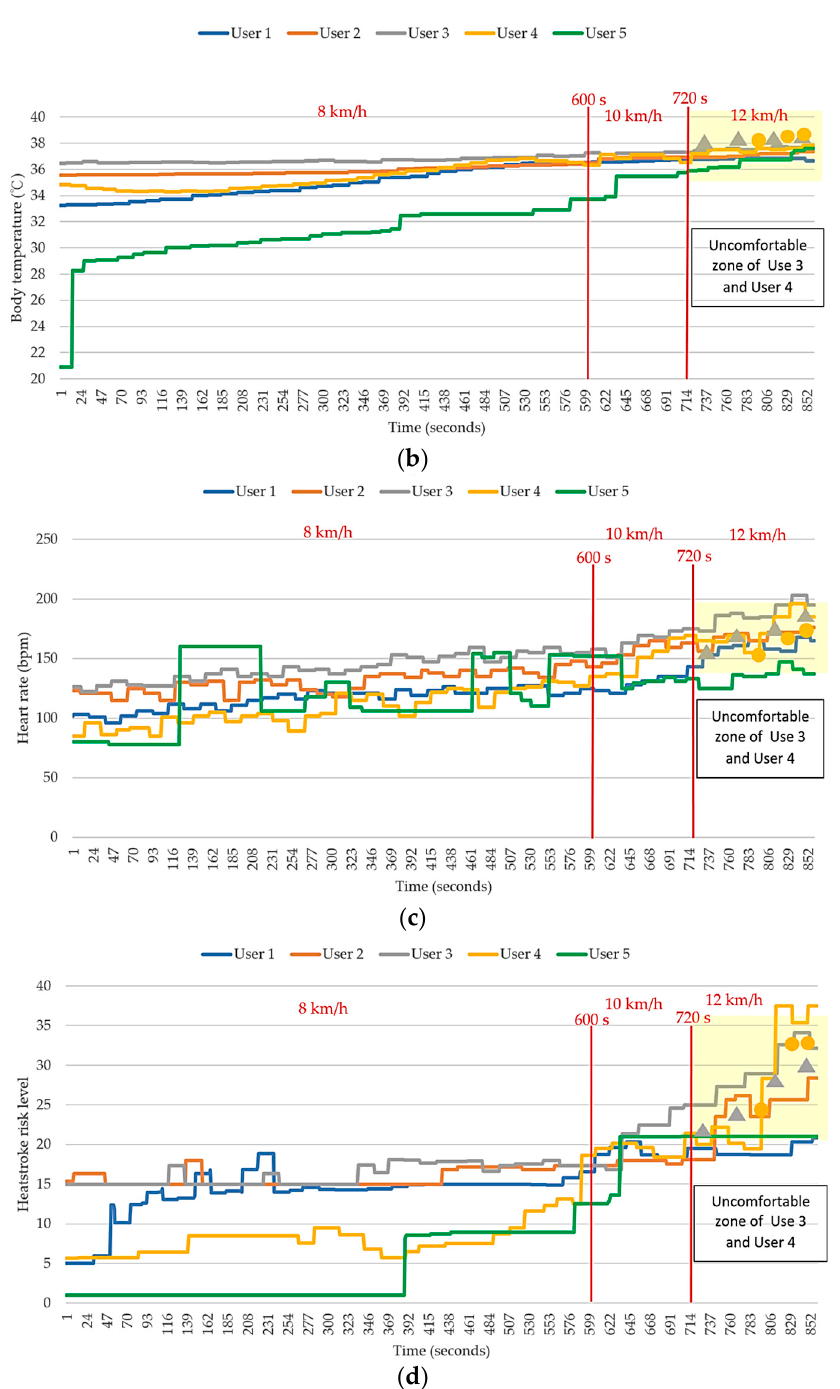
Figure 10. Comparison between the physiological data and the feedback signals of the four users during running. ( a ) Galvanic skin response (GSR); ( b ) body temperature; ( c ) heartbeat; and ( d ) heatstroke risk level.